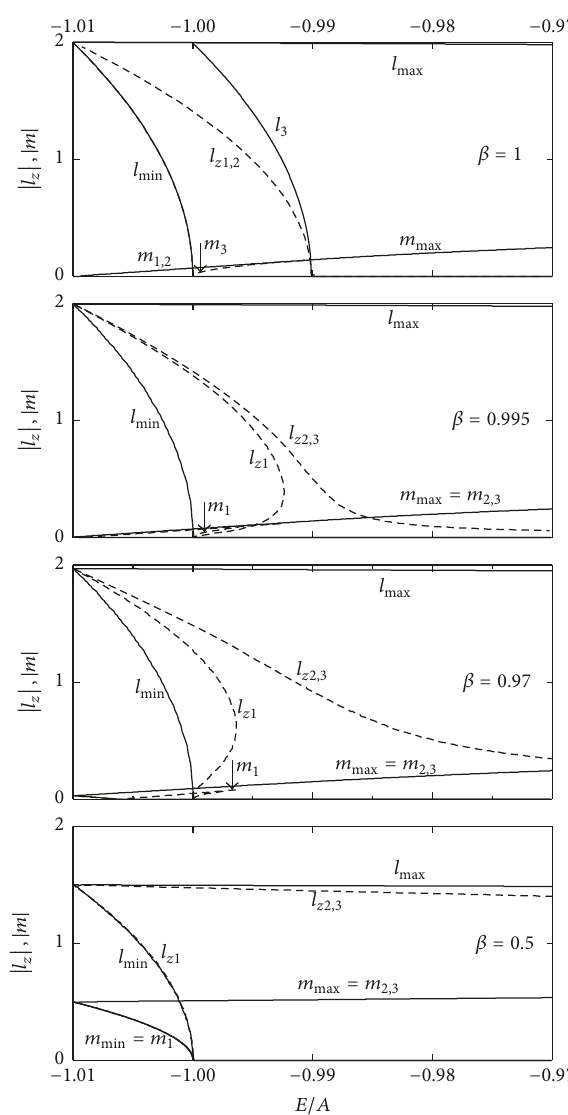
Figure 4: Ranges of the allowed projections of the total mag- netic moment 𝑚 and the vector of antiferromagnetism 𝑙 𝑧 on the anisotropy axis for ideal ( 𝛽 = 1 ) and “uncompensated” ( 𝛽 < 1 ) antiferromagnetic particles (see main text). Dashed lines 𝑙 𝑧1 , 𝑙 𝑧2 , and 𝑙 𝑧3 correspond to the normal uniform precession modes of magnetizations of sublattices M 1 and M 2